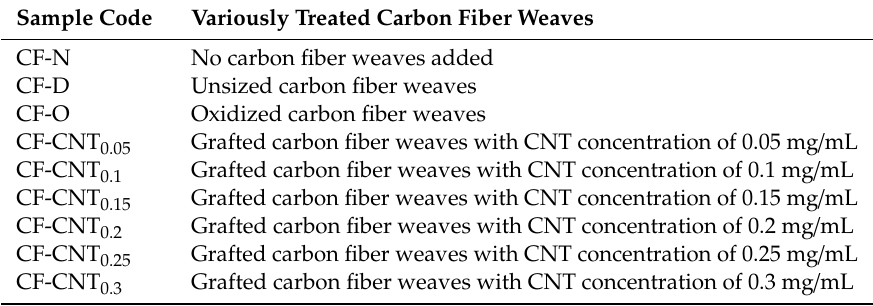
Table 1. Cured samples prepared from variously treated carbon fiber